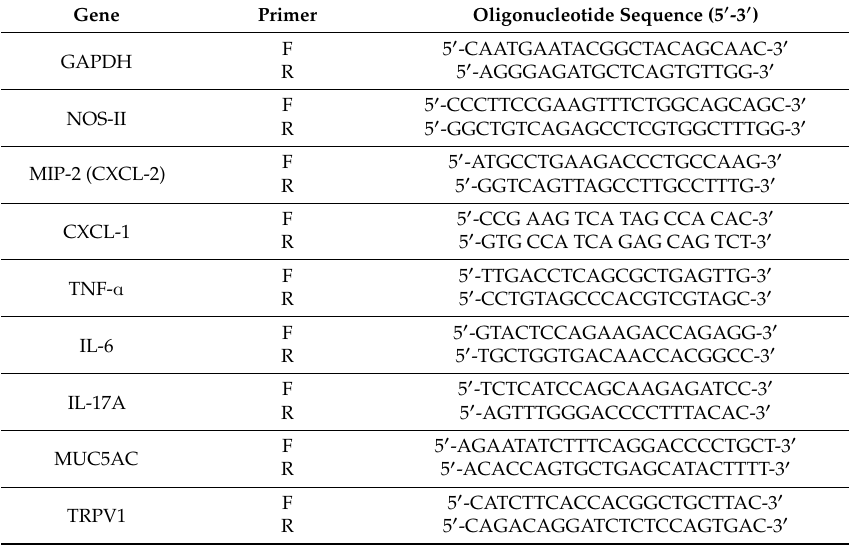
Table 1. Primers and probe sequence used in real-time PCR